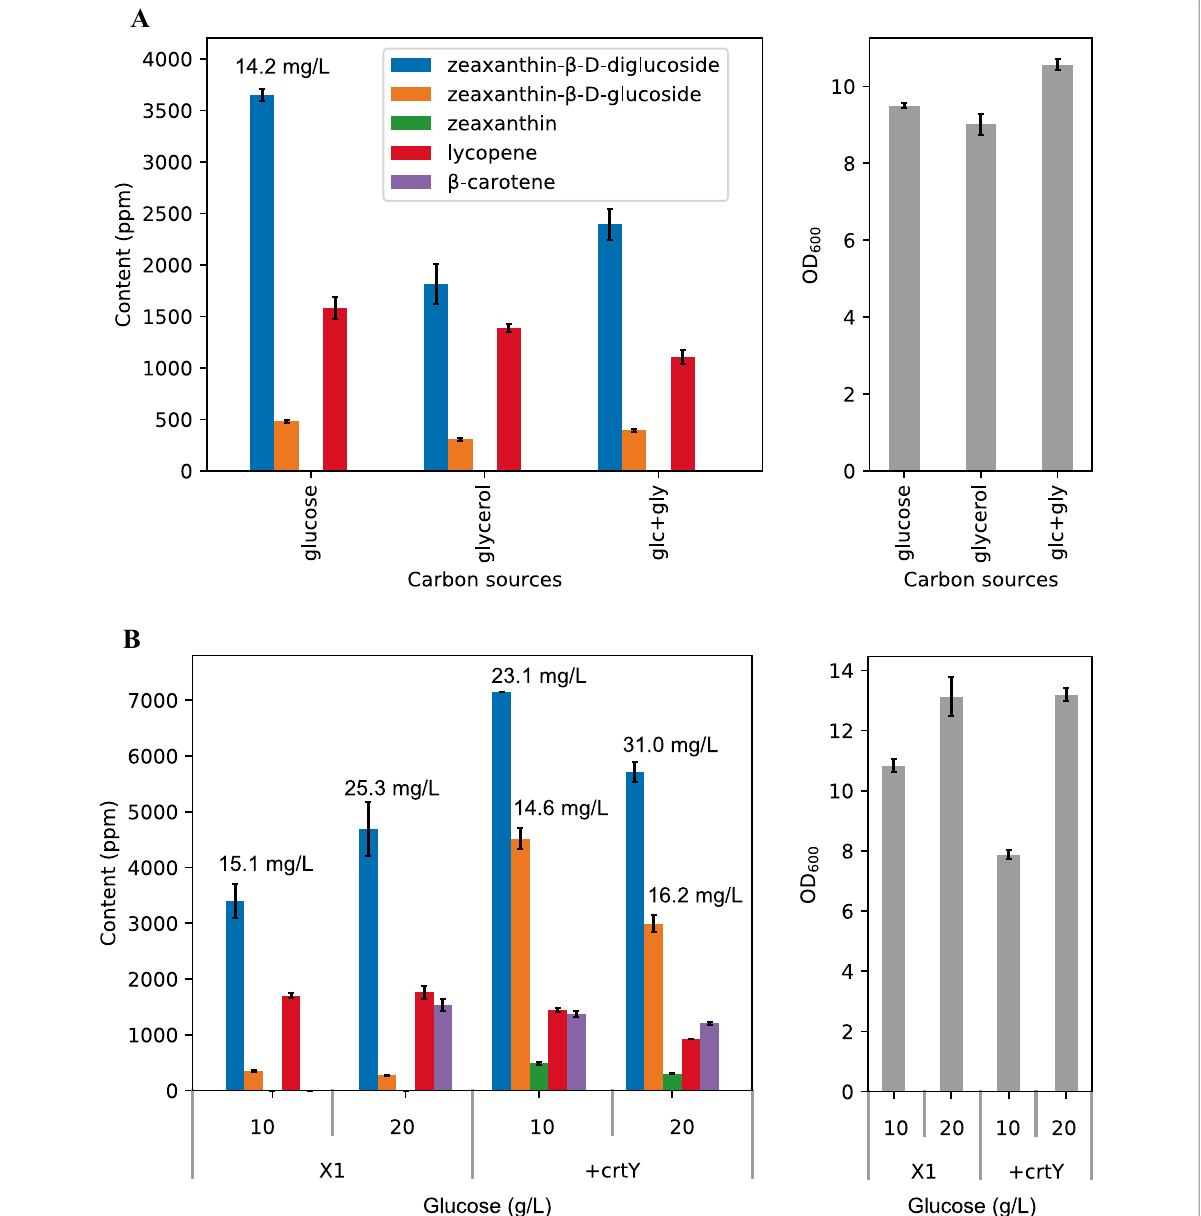
Fig. 4 The effects of carbon sources on the production of zeaxanthin glucosides. A Carotenoid contents and OD 600 of strain X1 by comparison of different carbon sources: 10 g/L glucose, 10 g/L glycerol and their mixture, 5 g/L